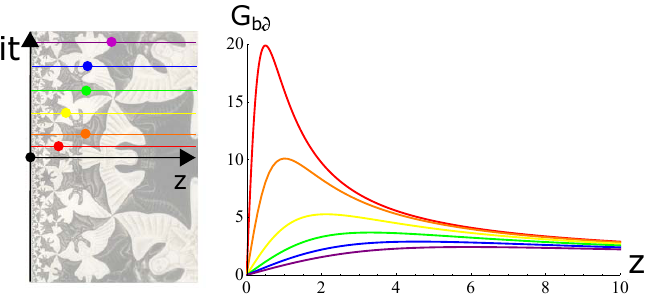
Figure 8 . Euclidean bulk-to-boundary two point function at zero temperature ( C = 1 / 2), as a function of radial coordinate z into the bulk. Red: t = 0 . 5, Orange: it = 1, Yellow: it = 2, Green: it = 3, Blue: it = 4, Purple: it = 5.